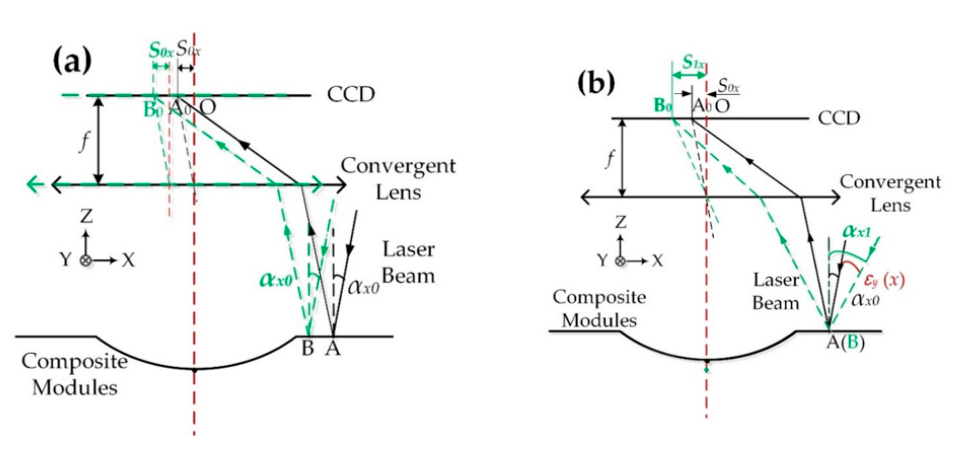
Figure 4. XOZ section of the measurement system, when detected at the plane surface: ( a ) The micro-angle sensor has a displacement in the X direction; ( b ) The micro-angle sensor has a pitch error ε y ( x )